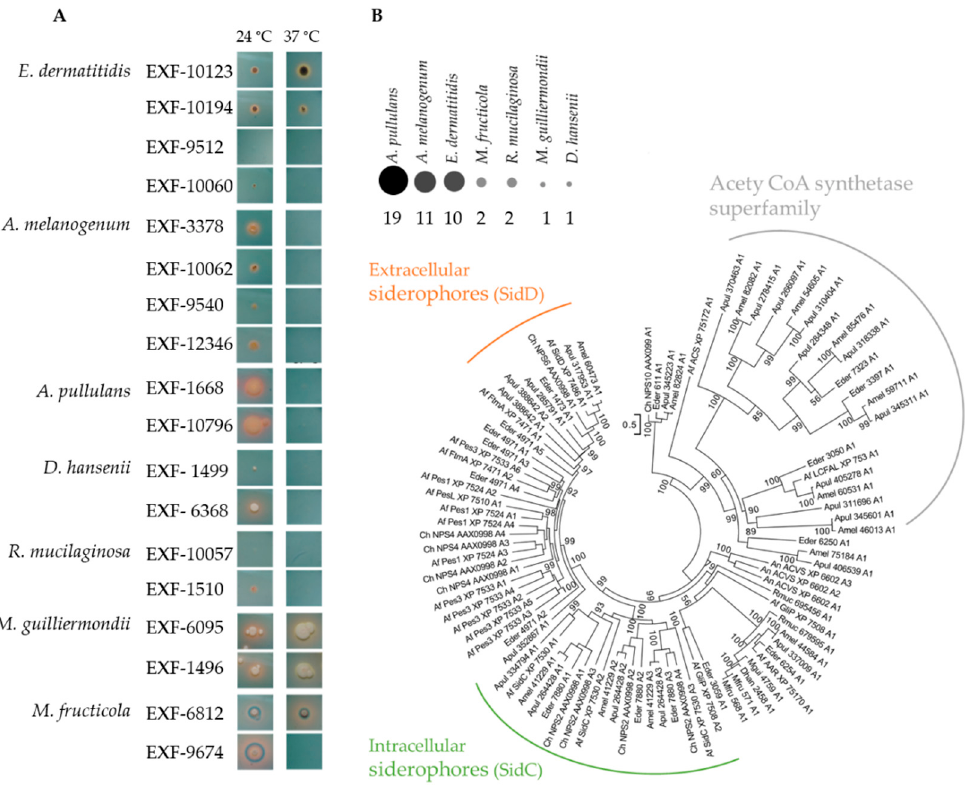
Figure 3. ( A ). Production of siderophores by the selected yeast strains on chrome azurol S agar (CAS) (yellow to orange halos around colonies indicate siderophore production). ( B ). Prediction of the non-ribosomal peptide synthetases (NRPSs) in the proteomes of the selected yeast strains, together with the phylogenetic tree of their adenylation domains. The size and color intensity of dots corresponds to the number of homologues.